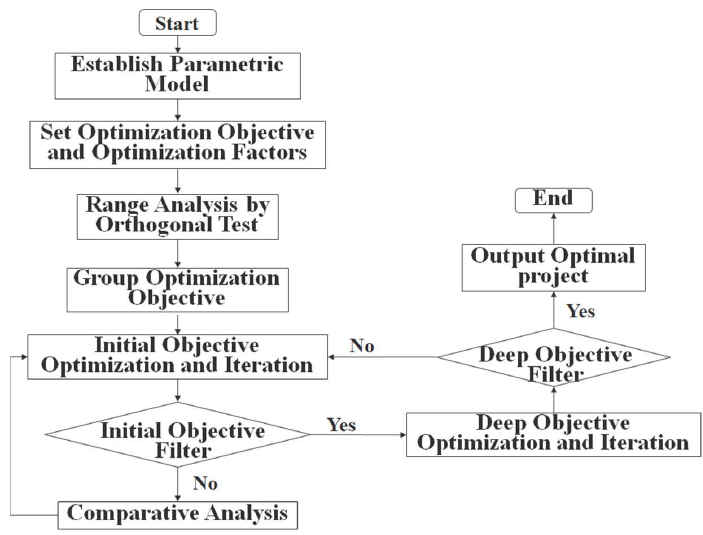
Figure 9. Multistrategy adaptive optimization algorithm flow.